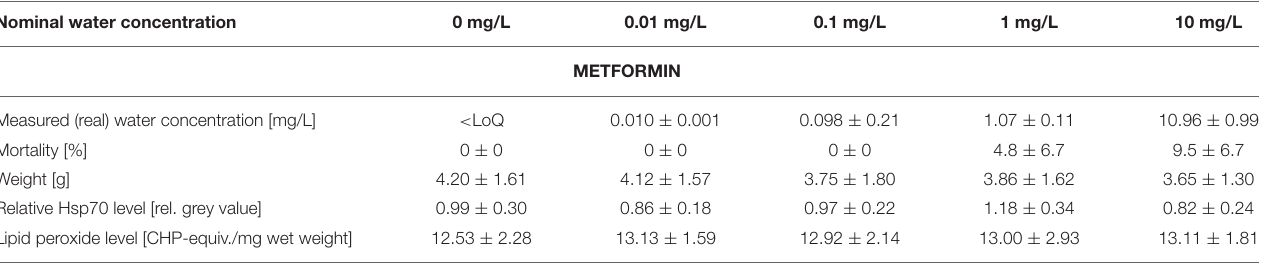
TABLE 1 | Summary of measured metformin water concentrations as well as data on mortality, weight, stress proteins, and lipid peroxides measured in big ramshorn snails exposed to metformin. Nominal water concentration